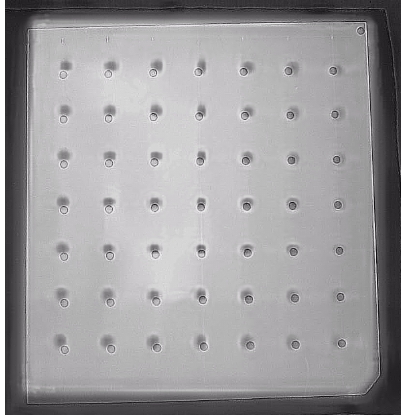
Figure 2. MSX image of the test field